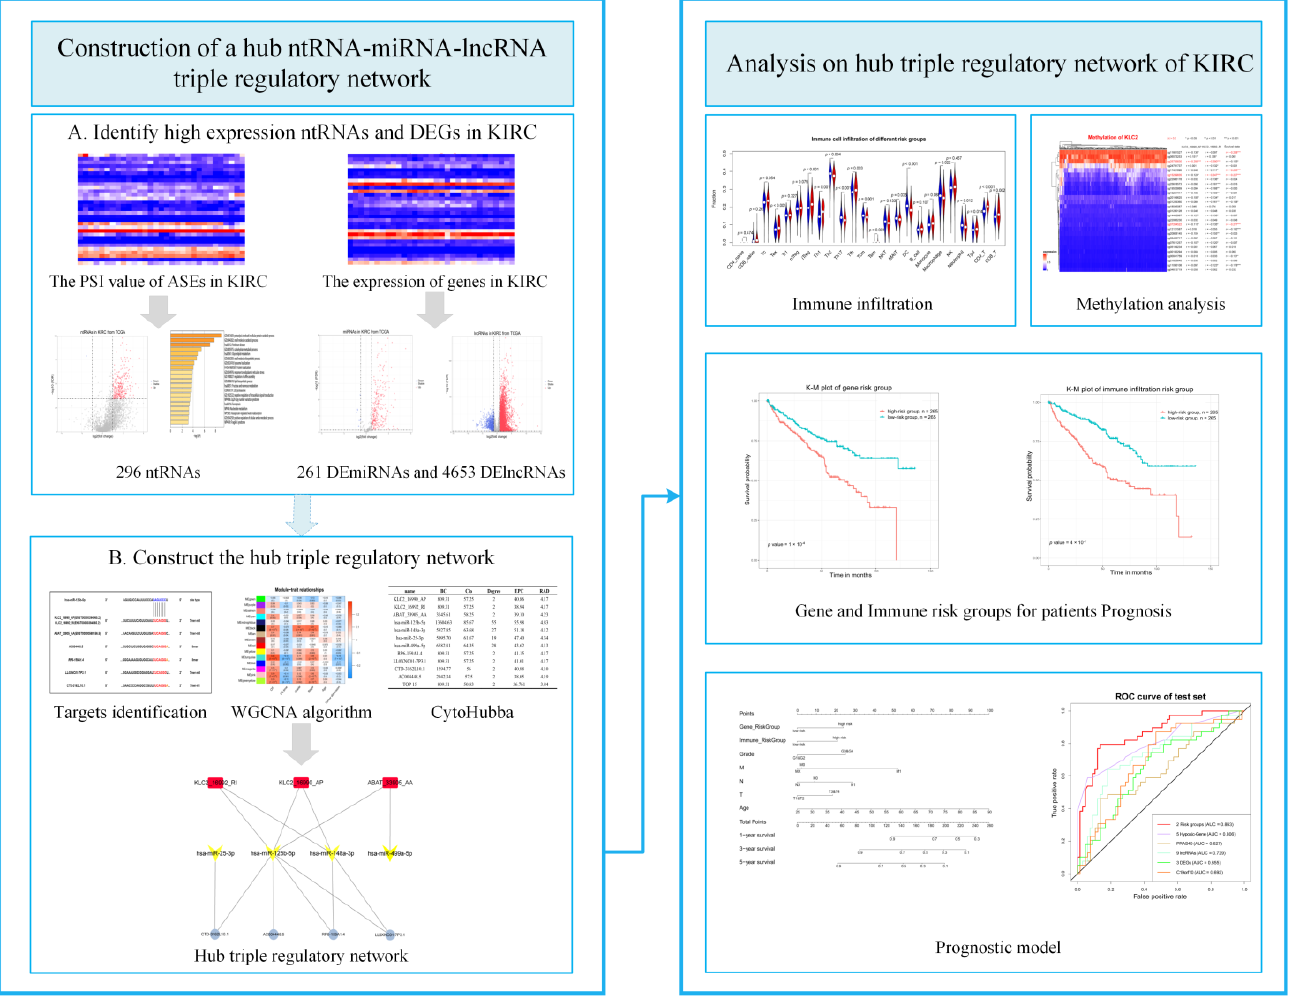
Figure 1. Research methodology of construction and analysis of a hub ntRNA–miRNA–lncRNA triple regulatory network in KIRC.